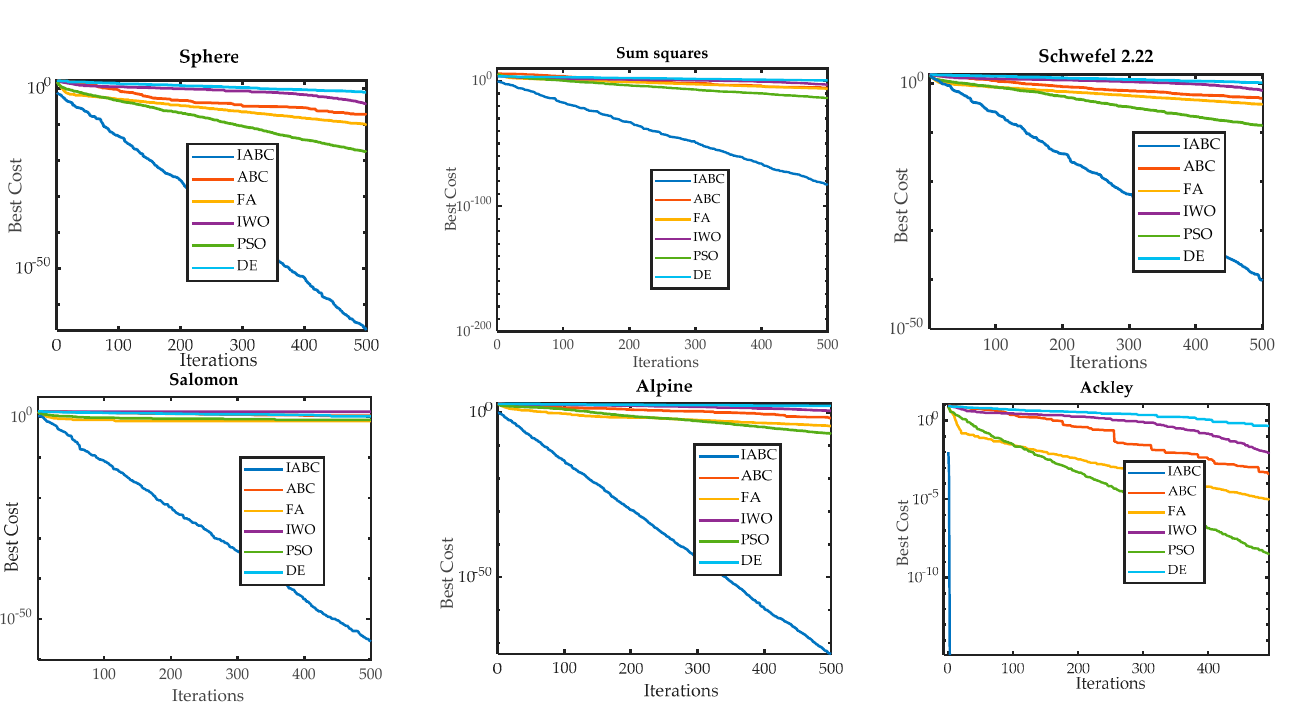
Figure 3. Comparison of convergence